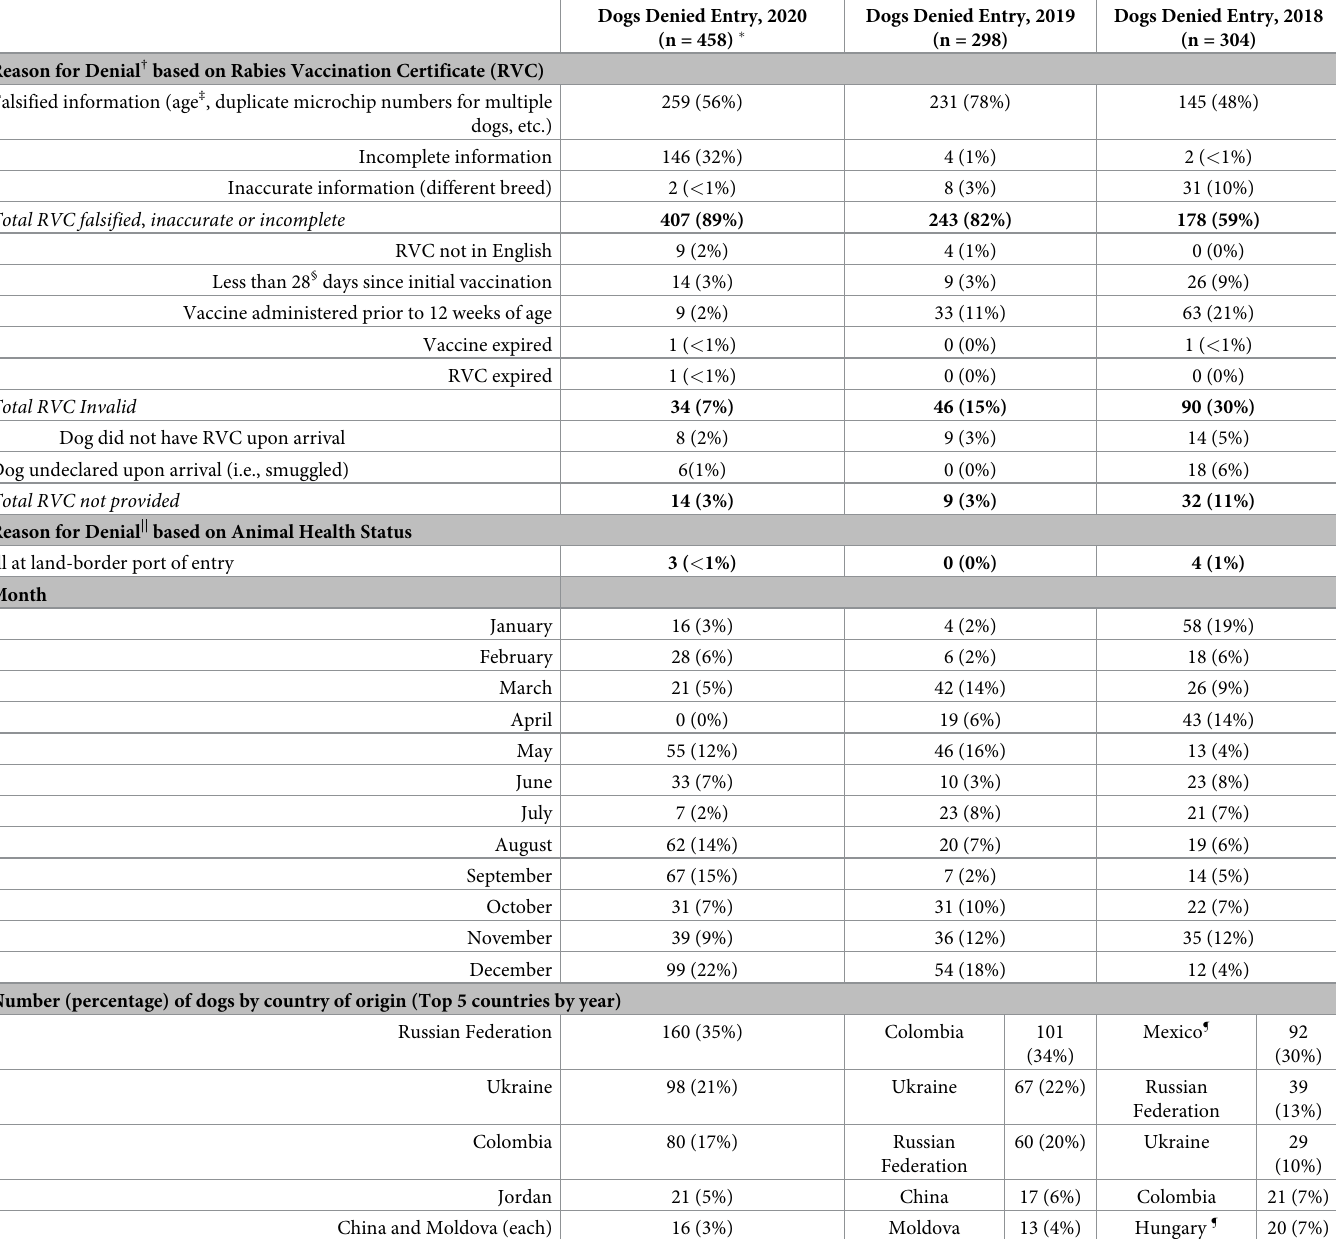
Table 1. Summary data for dogs denied entry to the United States by year, January 1, 2018—December